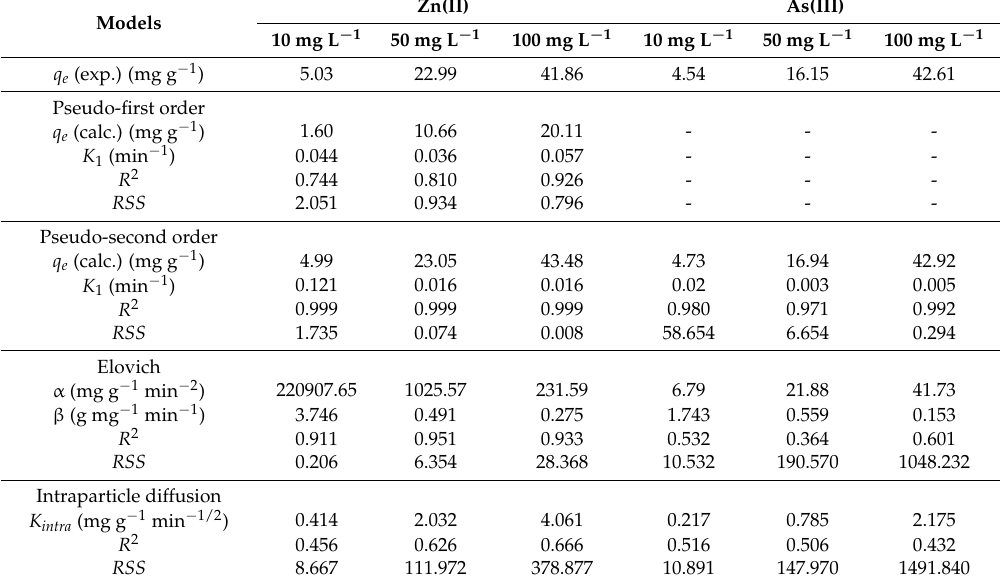
Table 3. Kinetic parameters for the uptake of Zn(II) and As(III) from aqueous solutions by adsorption onto